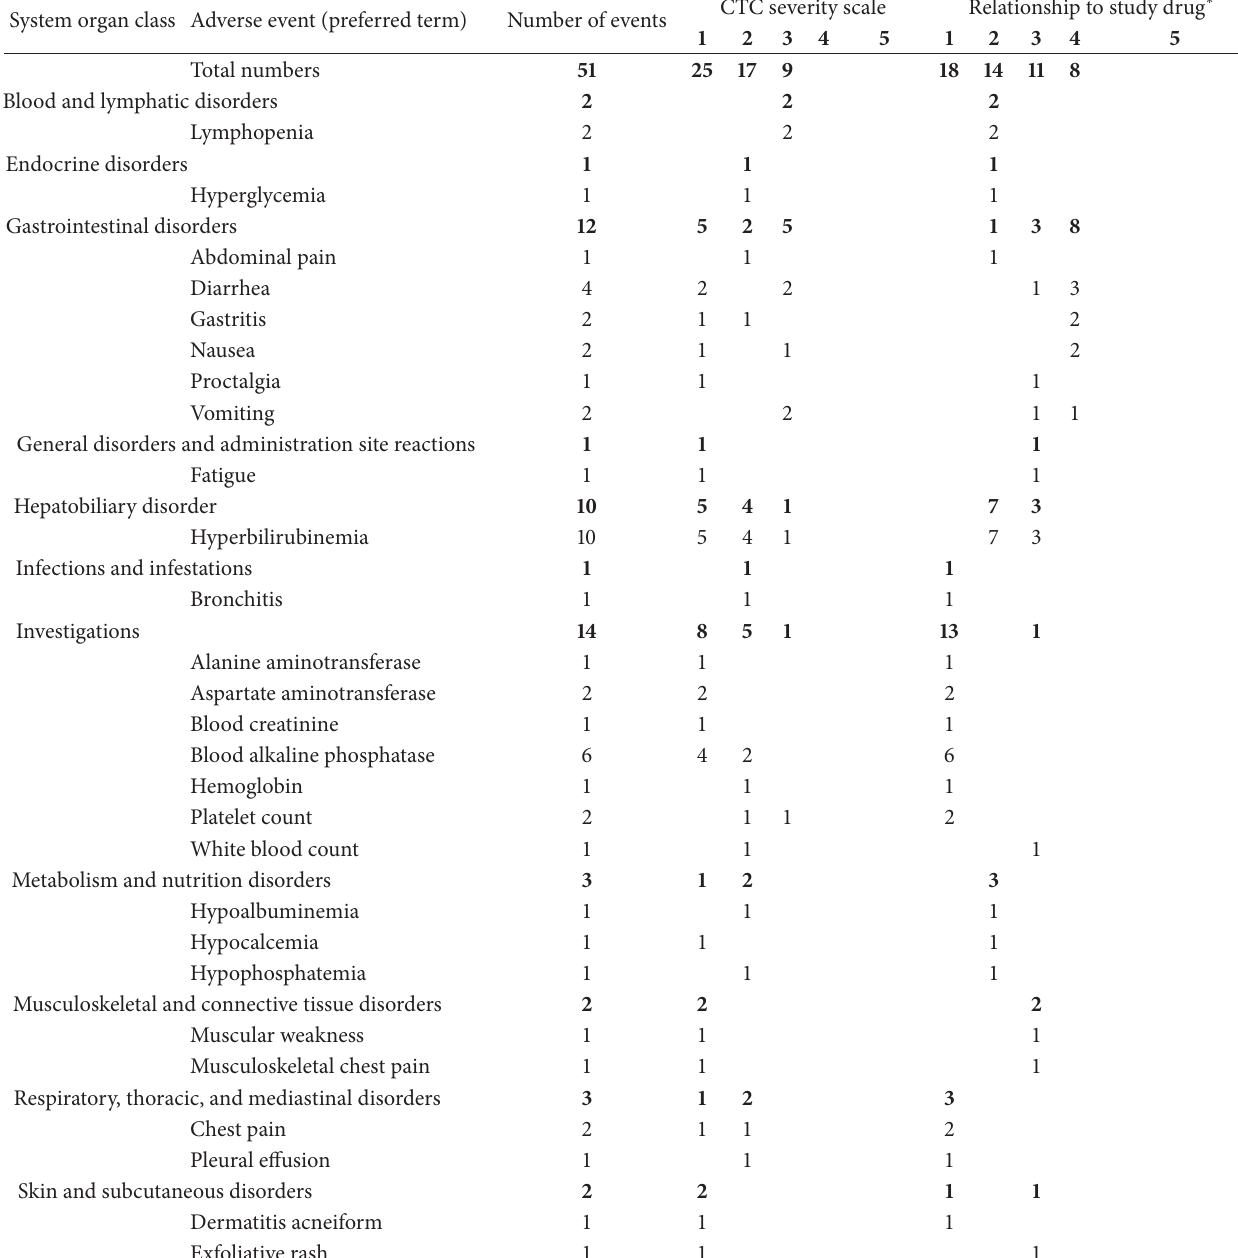
Table 2: Adverse events on study and reported relationship to study drug. System organ class Adverse event (preferred